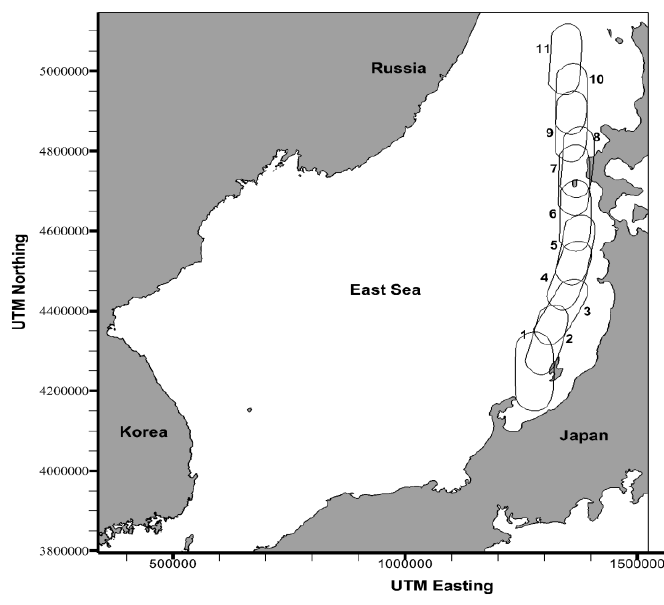
Figure 2. Locations of 11 hypothetical tsunamis.